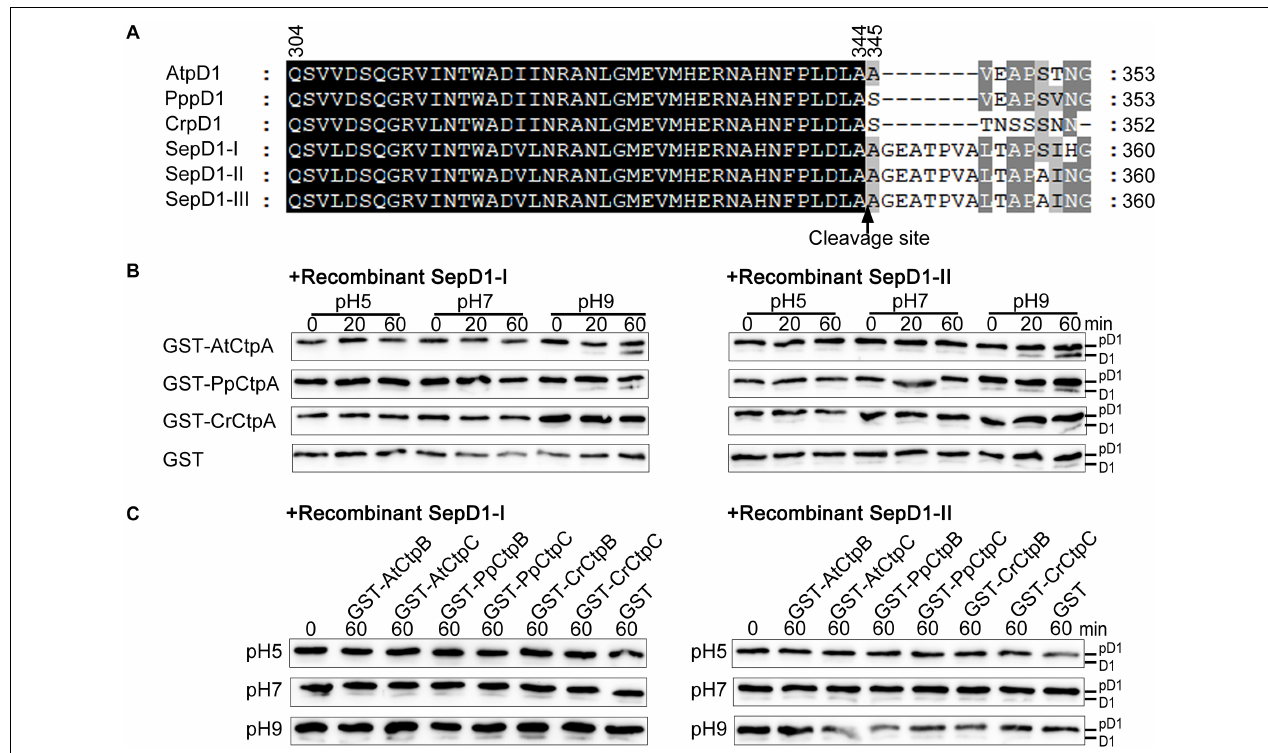
FIGURE 6 | Protease activity of eukaryotic Ctp on prokaryotic pD1. (A) C-terminal sequence comparison of pD1 from four evolutionary lineages of oxygenic photosynthetic organisms. AtpD1 , A. thaliana pD1; PppD1 , P. patens pD1; CrepD1 , C. reinhardtii pD1; SepD1 -I, -II, and -III, S. elongatus PCC 7942 pD1-I, -II, and -III. The numbers indicate the positions of the corresponding amino acids in pD1. The C-terminal cleavage site between amino acids 344 and 345 is indicated by a vertical arrow. (B) In vitro protease activity assays of eukaryotic CtpA using as substrate recombinant SepD1 -I (left) and SepD1 -II (right), which were produced by fusing GST with the C-terminal 57 aa fragment of SepD1 -I or SepD1 -II. The experiments were conducted as described in the legend of Figure 4 . (C) In vitro protease activity assays of eukaryotic CtpB and CtpC using as substrate recombinant SepD1 -I (left) and SepD1 -II (right).